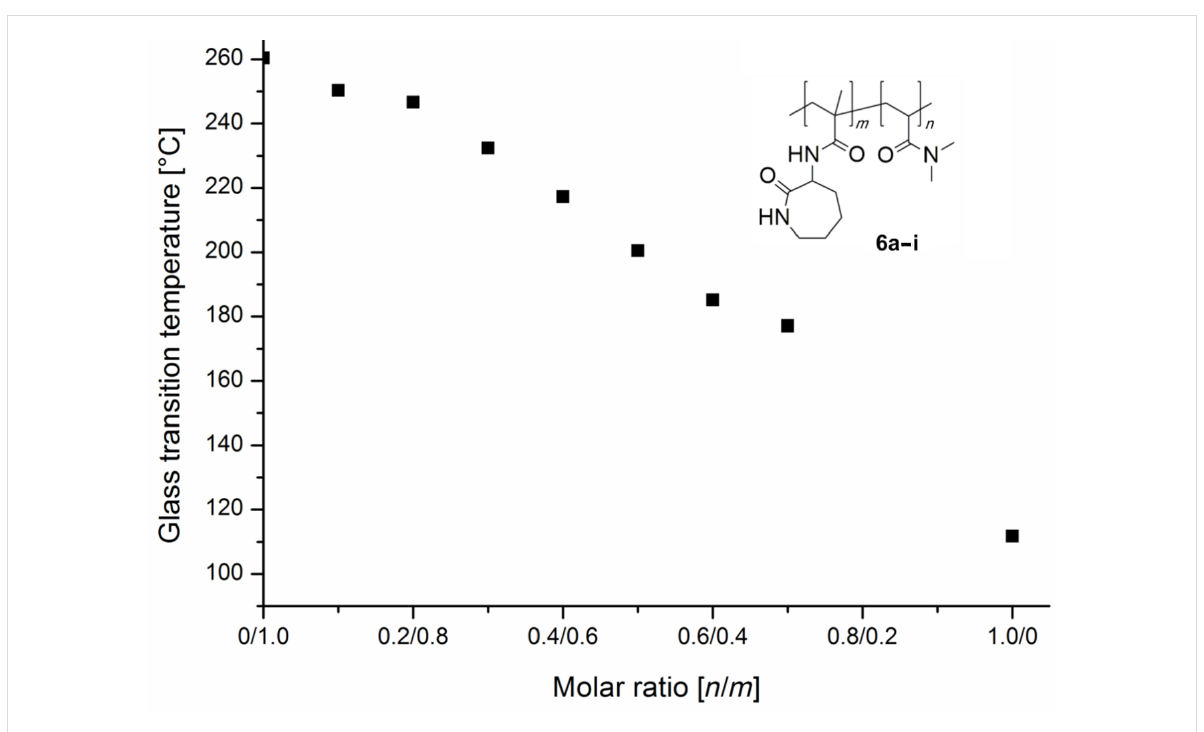
Figure 5: Glass-transition temperature as a function of the amount of N , N -dimethylacrylamide ( 5 ) in the copolymers 6a–i .